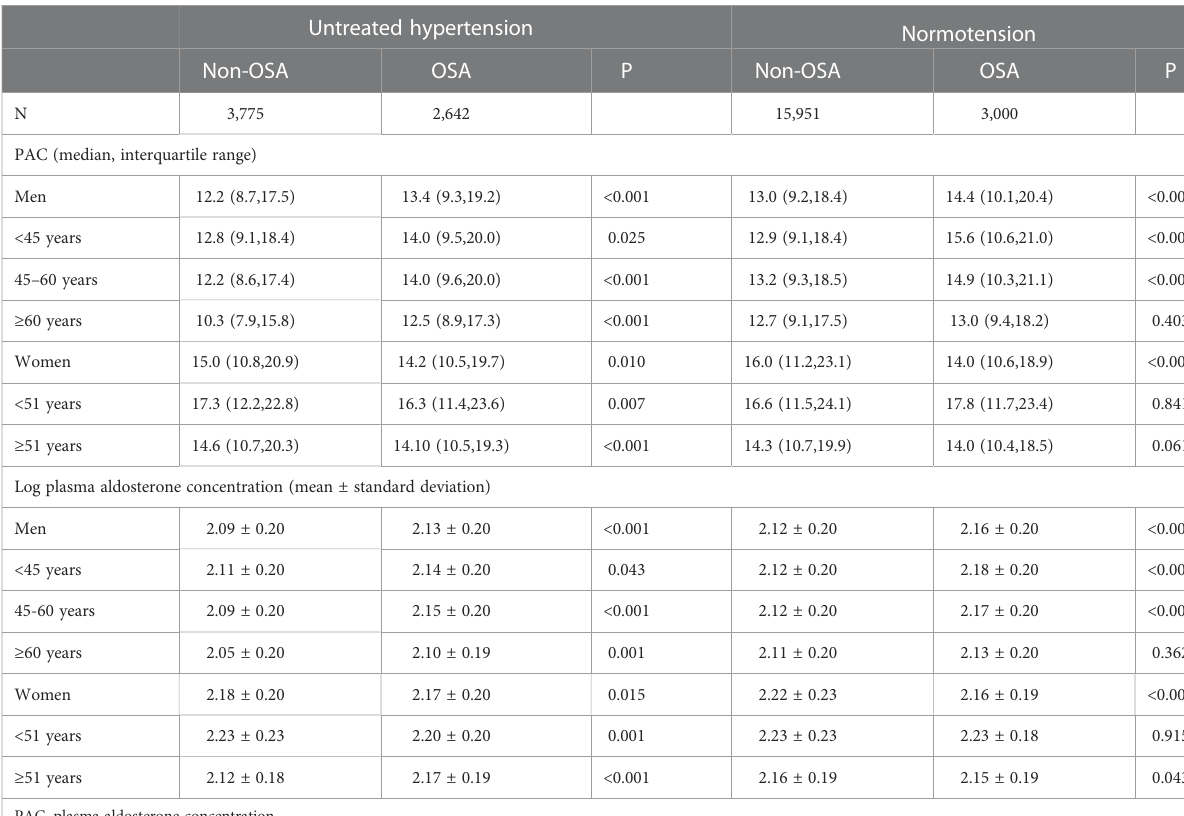
TABLE 5 Comparison of PAC and log PAC between total, men, and women participants with and without OSA by presence of hypertension and by age in community-based